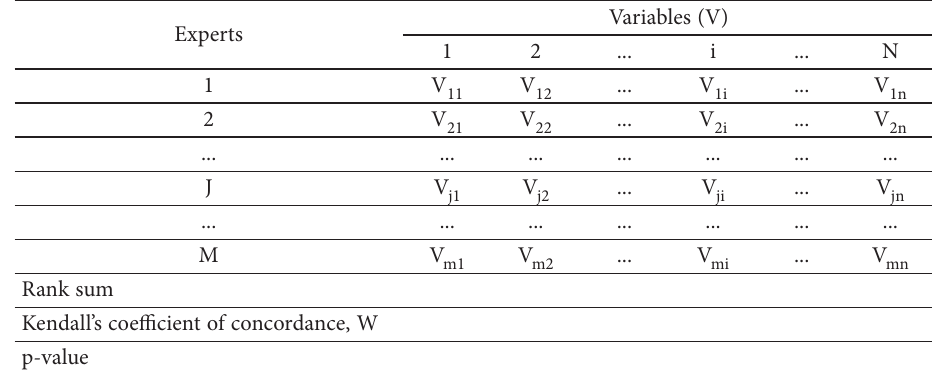
Variables (V) 1 2